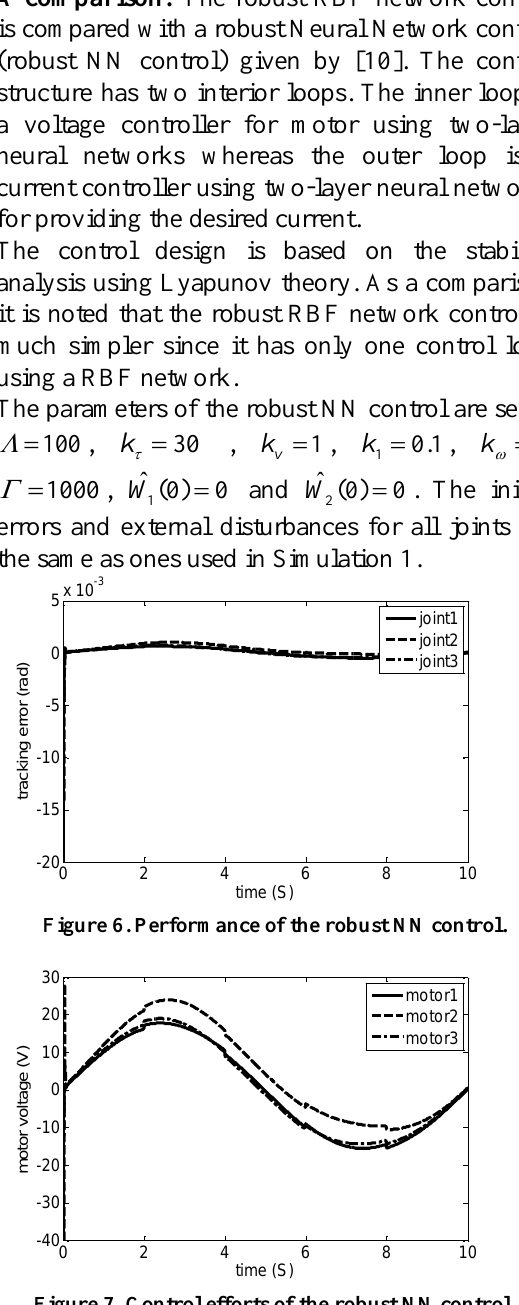
5 4.2 10 rad   without overshoot.